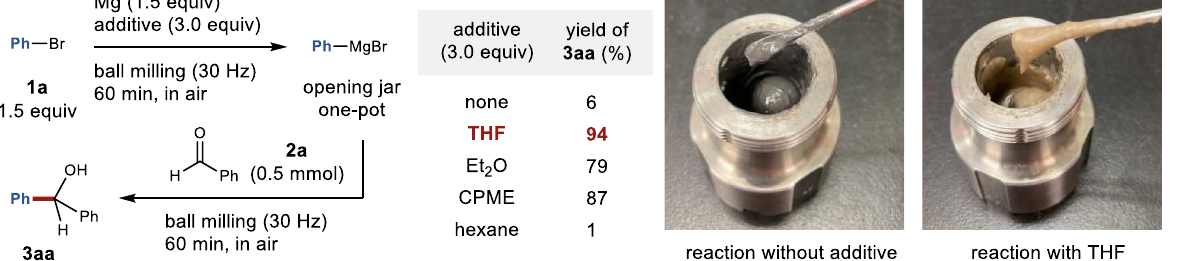
Fig. 1 Synthesis of organomagnesium nucleophiles using mechanochemistry and their application to organic synthesis. a Conventional solution-based method for the preparation of Grignard reagents. b Previous attempts to mechanochemically synthesize organomagnesium nucleophiles. c Mechanochemical synthesis of organomagnesium nucleophiles and their application to organic synthesis. d Optimization study for the formation of magnesium-based nucleophiles using ball